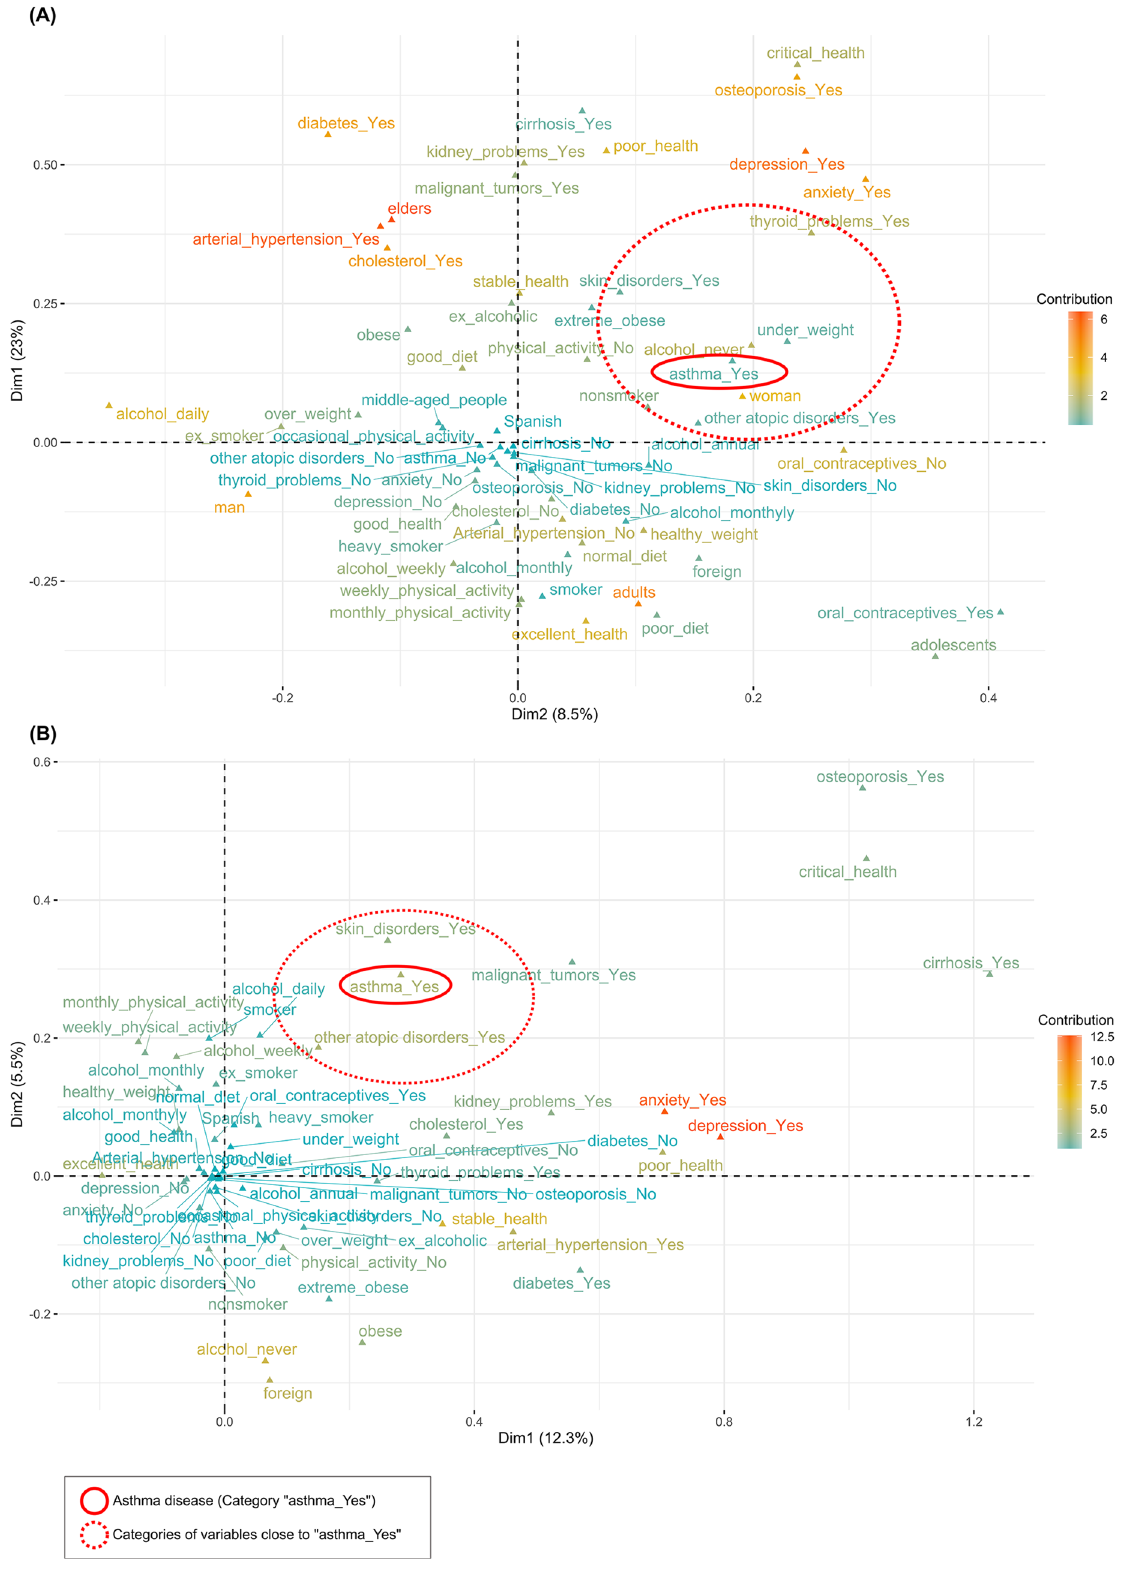
Figure 2. Representation of MCA (multiple corresponde analysis) results performed on data collection from European Health Survey in Spain 2014 (EHSS-2014). ( A ) All data collected from the EHSS-2014. ( B ) Open cohort of 18- to 45-year-old women constructed using the